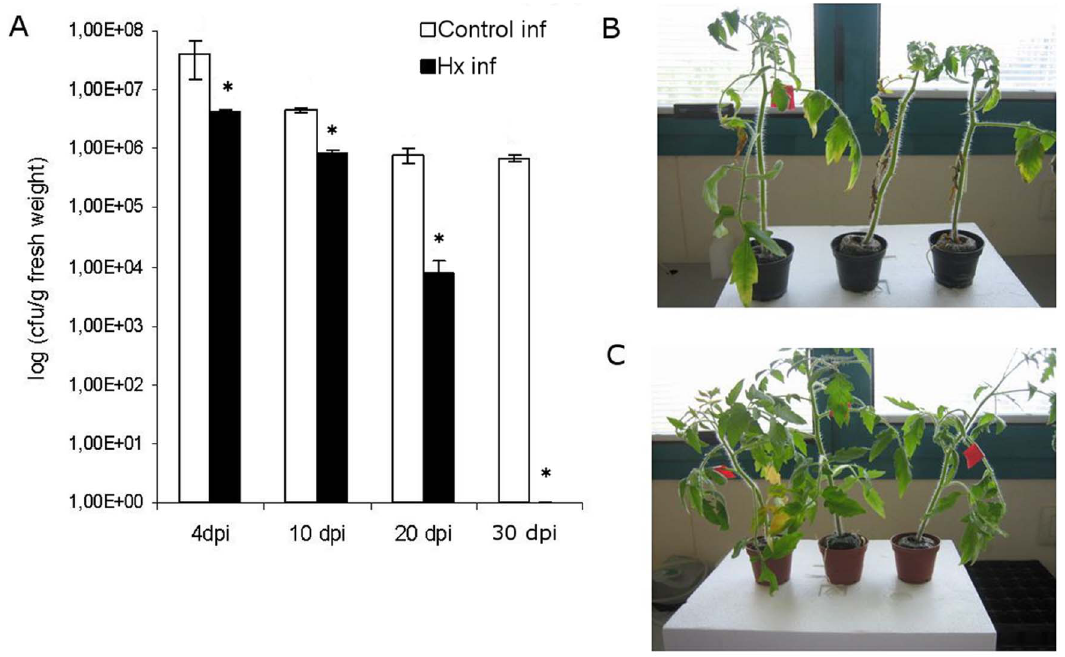
Figure 10. Hx treatment has a long lasting effect. Plants were treated with 0.6 mM Hx and dip inoculated. The bacterial growth was evaluated at 4, 10, 20 and 30 days after inoculation with P.syringae DC3000 (10 5 cfu/ml) (A). The pictures of representative untreated (B) and Hx treated (C) plants were taken 20 days after inoculation.